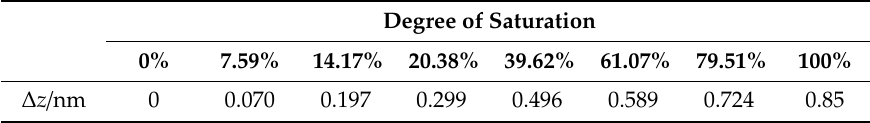
Table 3. Deformation of C–S–H in the z direction (interlayer spacing direction) with different degree of saturation.